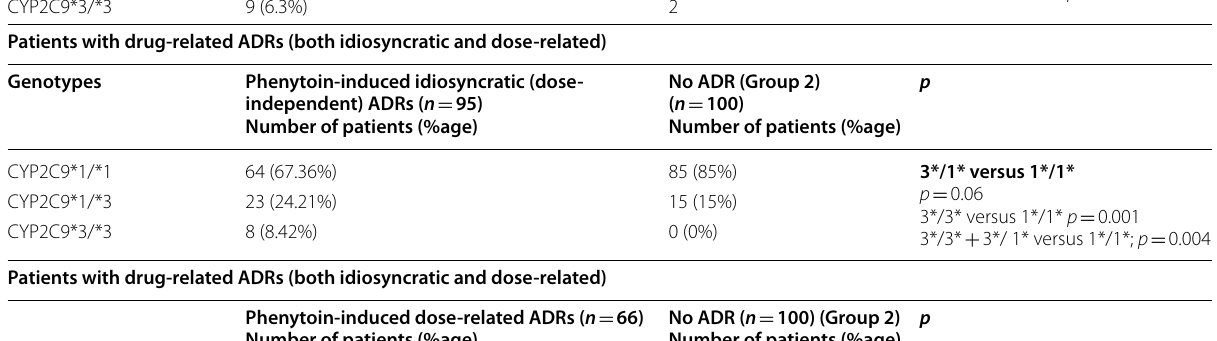
Patients with drug-related ADRs (both idiosyncratic and dose-related)